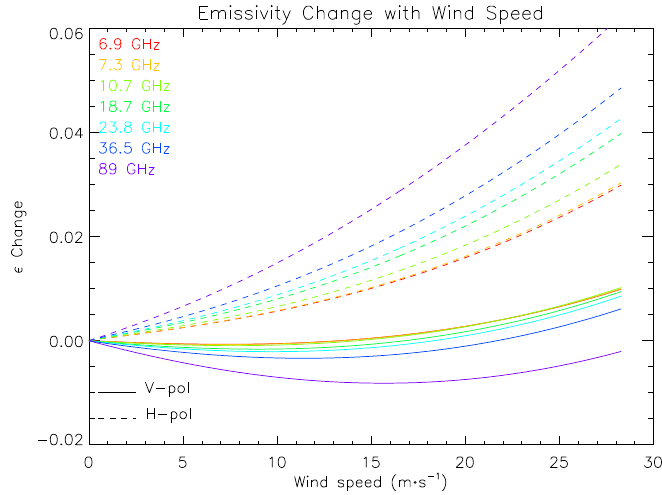
Figure 2. The change in emissivity as a function of wind speed using the FASTEM model for sea surface temperature (SST) = 297 K . All channels are included ranging from 6.9 GHz (red) to 89 GHz (purple) with V-polarized channels indicated by solid lines and H-polarized channels by dashed